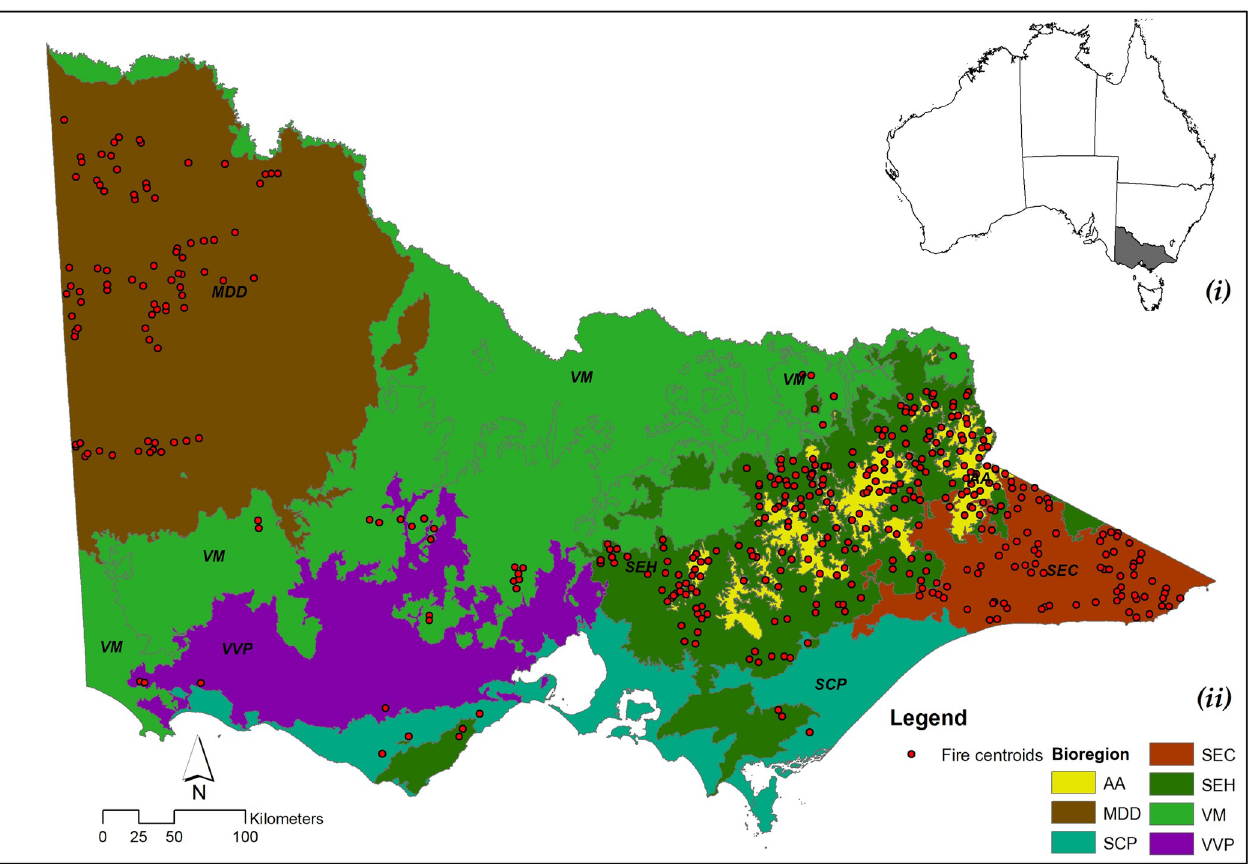
Fig 1. Map of study area. ( i ) Victoria highlighted (grey) in the map of Australia; ( ii ) Locations of study areas within the state of Victoria in south-eastern Australia. Red points rrepresent the centroids of the 162 wildfires investigated in this study. Colours relate to bioregions (Acronyms are defined in Table 1).